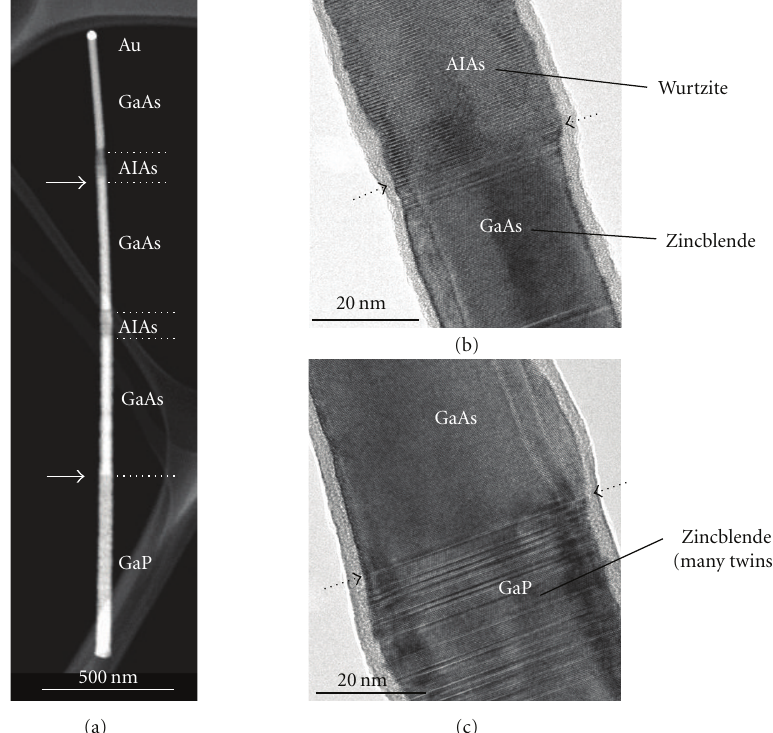
Figure 5: An AlAs/GaAs/GaP heterostructure nanowire. (a) A HAADF-STEM image; (b) and (c) HRTEM images of the areas near AlAs/GaAs and GaAs/GaP interfaces, respectively